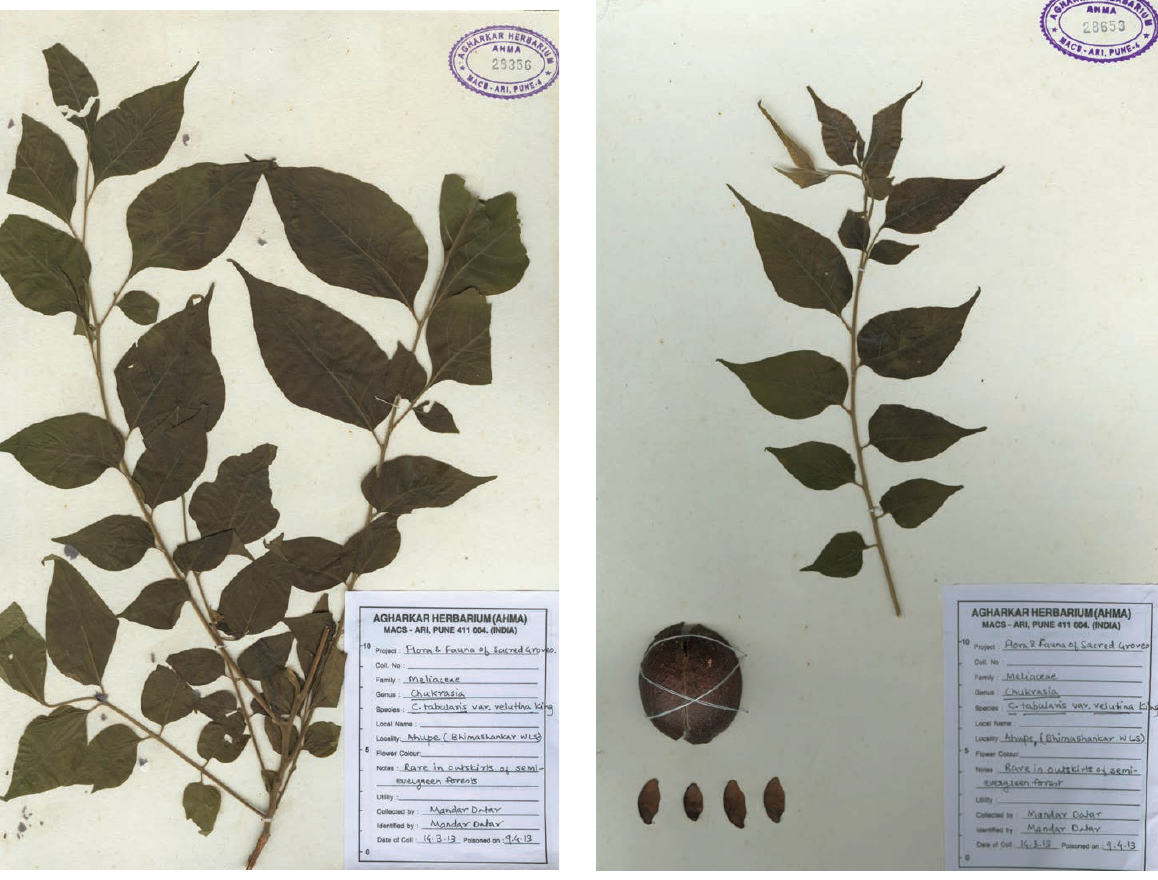
northernmost record in the Western